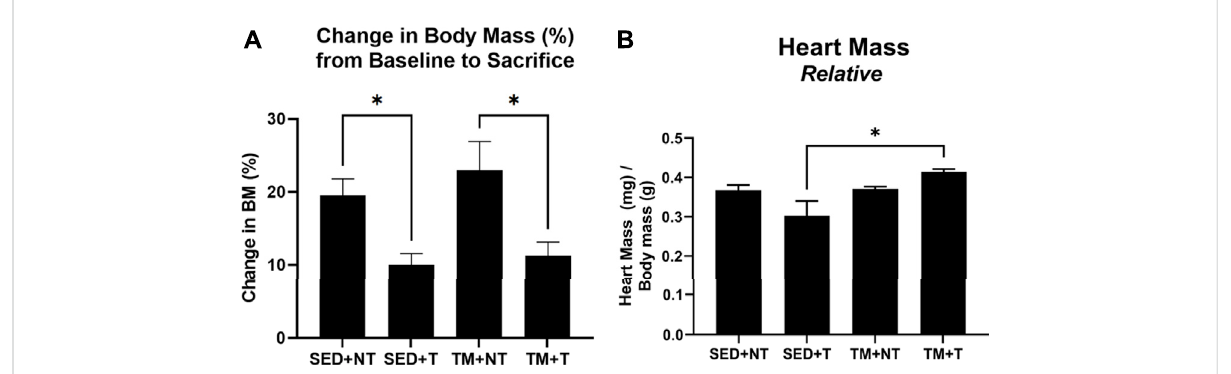
FIGURE 1 Change inBody Mass Overtime and Relative CardiacMass atSacri fi ce.Tumorbearingloweredbody mass (A) .SED + Tgroup exhibitedsmallest relative cardiac mass compared to all other groups and was signi fi cantly smaller than the TM + T group (B) . SED, sedentary; TM, preconditioning treadmill endurance exercise training; T, tumor bearing; non-tumor. Data are presented as mean ± SD. * p <